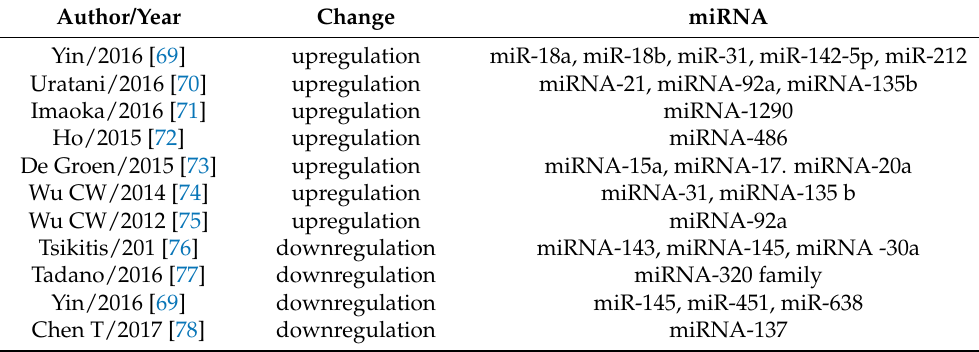
Table 2. According to Liu and Li dysregulated miRNAs in colorectal adenoma and carcinoma